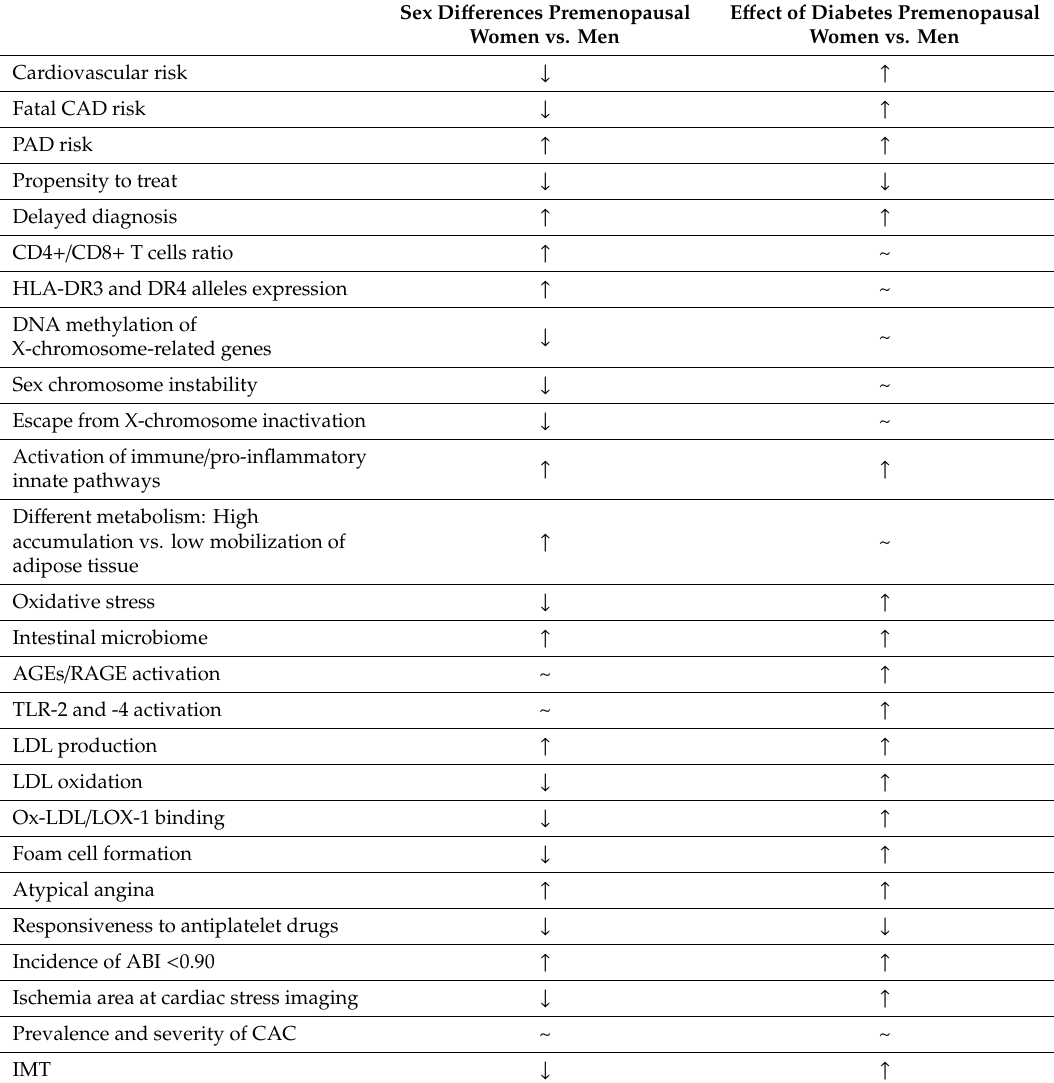
Table 2. Sex di ff erences and impact of diabetes on coronary atherosclerosis and ischemic heart disease. Sex Di ff erences Premenopausal E ff ect of Diabetes Premenopausal Women vs. Men Women vs.